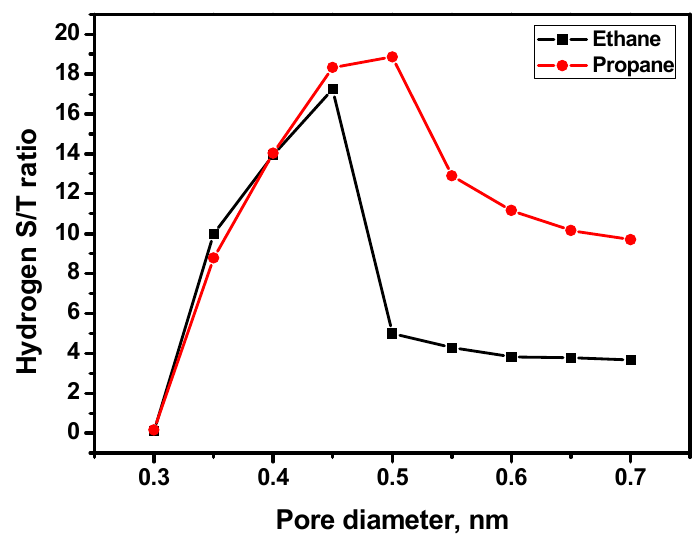
Figure 5. Dependence of the hydrogen S/T ratio on the pore diameter. The obtained hydrogen concentrations allow estimating the hydrogen productivity for both processes. The resulting dependences of this parameter on the pore diameter are shown in Figure 6. The maximal values correspond to the pore diameters of 0.45 nm (ethane) and 0.5 nm (propane). Further increase in the pore diameter decreases the hy- drogen productivity 1.6 and 1.3 times, accordingly. It should also be mentioned that propane dehydrogenation seems to be more efficient and preferable in terms of hydrogen productivity if compared with ethane dehydrogenation.